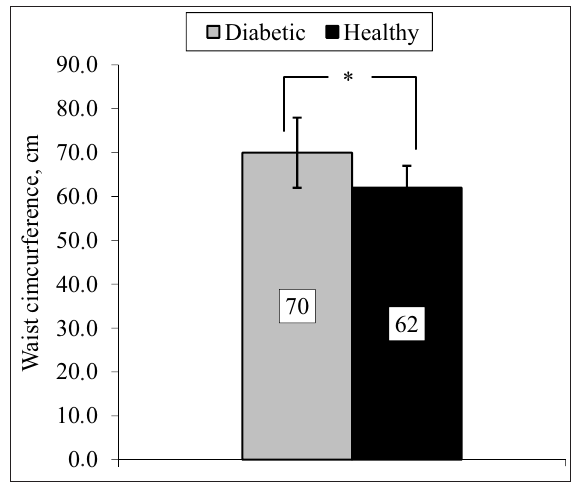
Figure 2. Waist circumference (cm) of diabetic and healthy young women